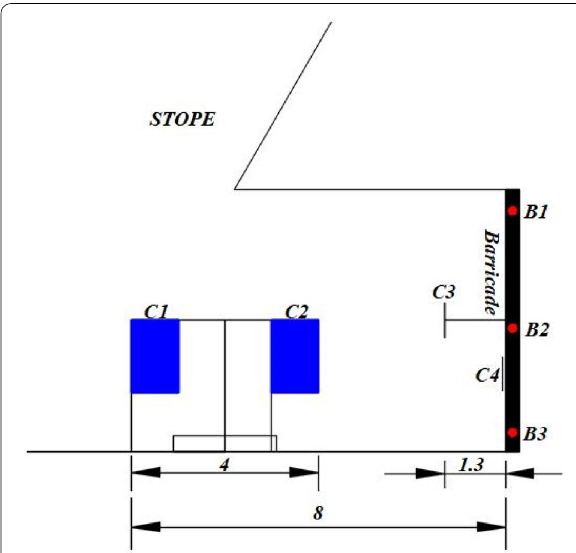
Fig. 12 Arrangement of the transducers at 67-SL1 stope and the barricade (dimension in